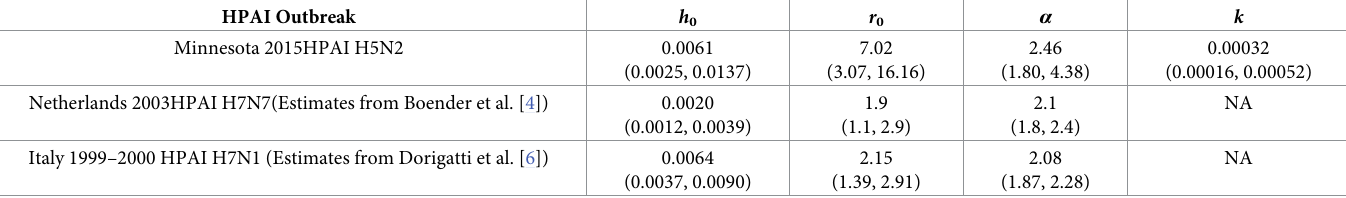
Table 2. Comparison of spatial transmission kernel estimates from Minnesota, the Netherlands, and